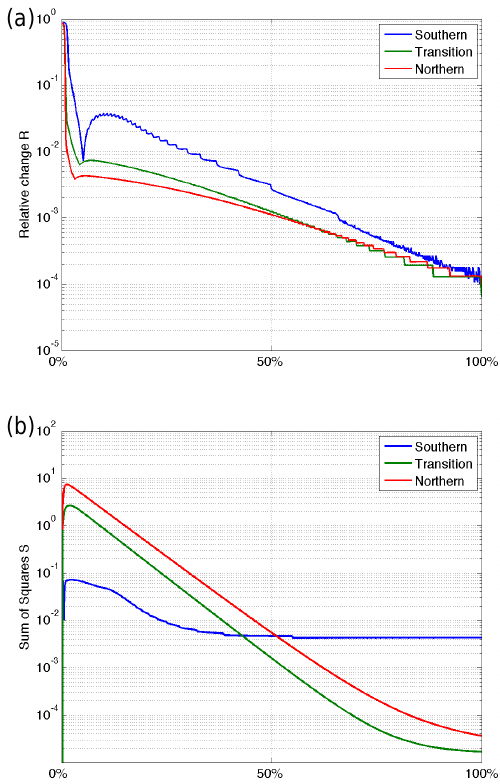
Figure 8. Temporal evolution of (a) the relative change of the sys- tem per time step R and (b) the sum of squares S for the three Fig. 8: Temporal evolution of (a) the relative change of the reference stations. On the x axis the time is given as the percentage system per time step R and (b) the sum of squares S for the of the total duration until the equilibrium is reached. The y axis is three reference stations. On the x-axis the time is given as in logarithmic the percentage of the total duration until the equilibrium is reached. The y-axis is in logarithmic scaling.